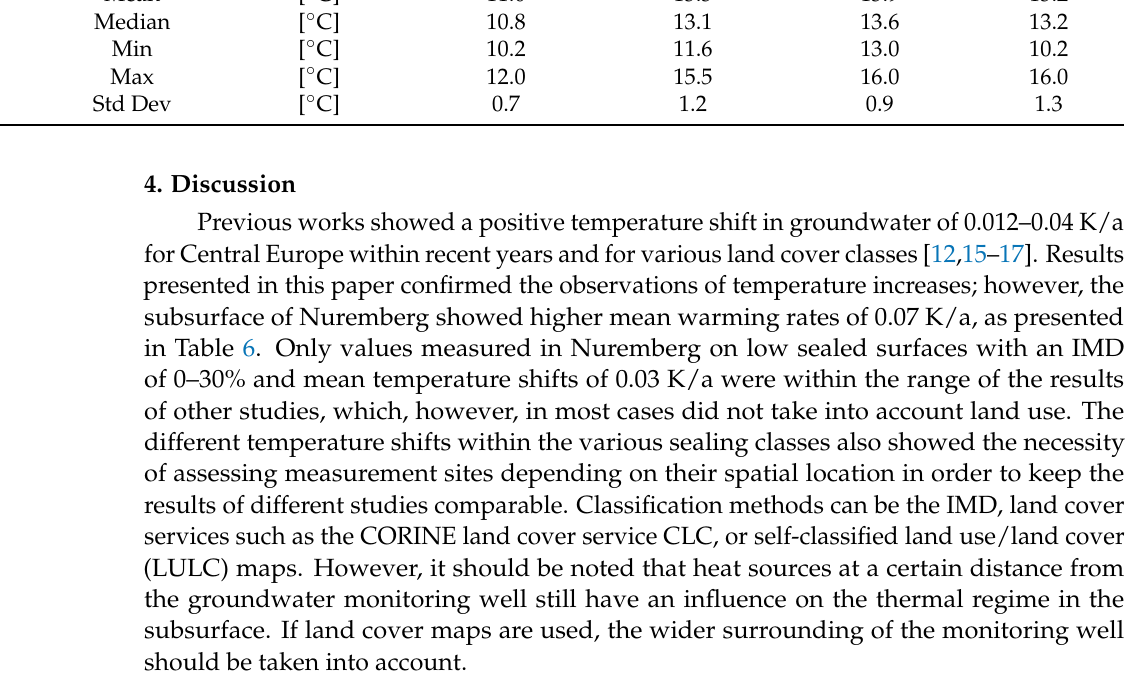
Table 6. Comparison of groundwater temperature shifts in different studies for Central Europe.